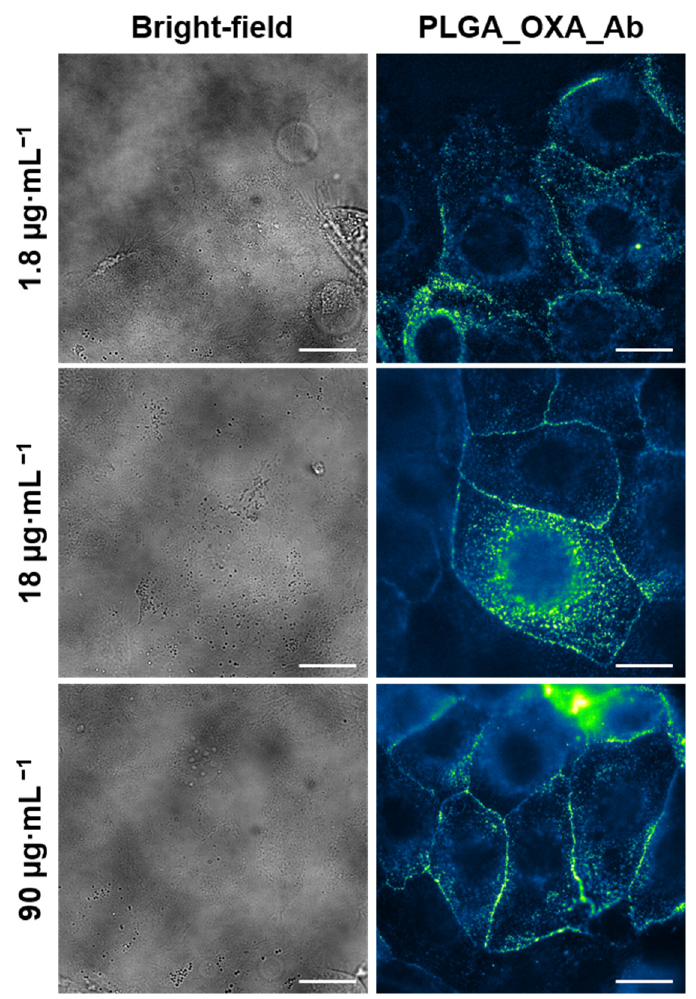
Figure 10. Fluorescence microscopy images of human cells derived from colorectal carcinoma (CaCo-2) treated with oxaliplatin-containing PLGA nanoparticles coated with anti-CD133 antibody conjugated to Alexa Fluor 488 (PLGA_OXA_Ab). The CaCo-2 cells were treated with 1.8–90 µg·mL − 1 concentration of the PLGA_OXA_Ab for 30 min. Left—bright-field images of the cells. Right—fluorescence emission of cells treated with PLGA_OXA_Ab (false-colored based on the fluo- rescence emission intensity). The scale bars correspond to 20 µ